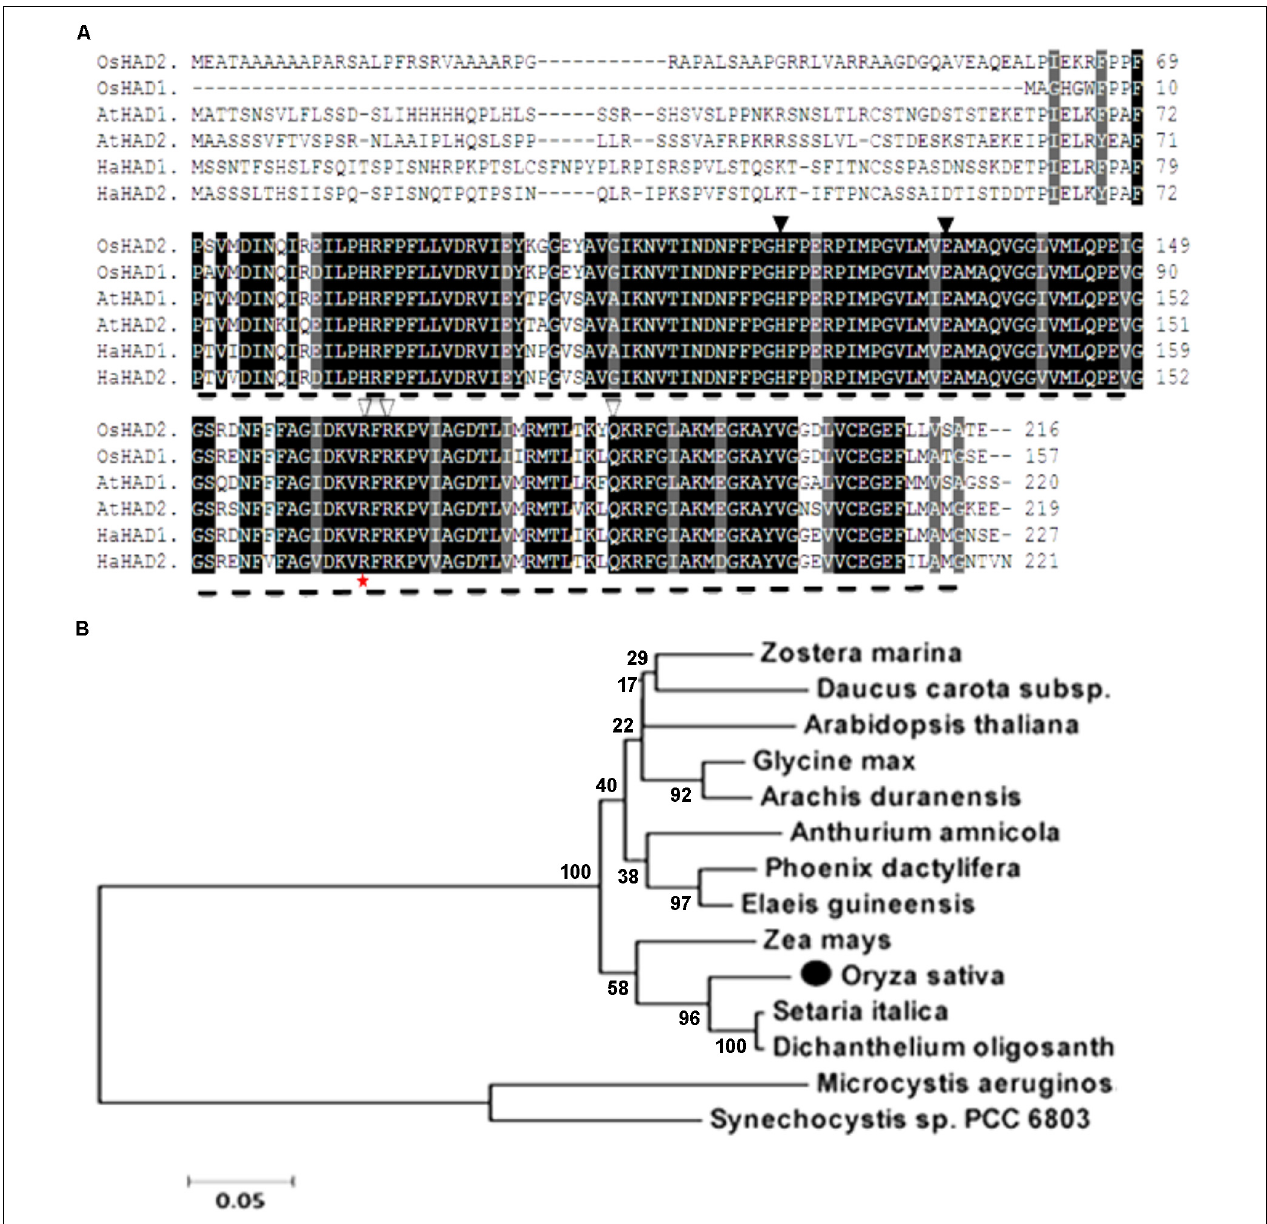
FIGURE 6 | Alignment of the predicted amino acid sequence and phylogeny of ZL16. (A) Amino acid sequence alignment of ZL16 (O sHAD1 ). Dash line denotes FabA-like domain. Identical residues are highlighted as black shadings, highly conserved residues as dark gray shadings and weakly conserved residues as light gray shadings. Black triangles indicate the active sites, and white triangles are the residues participating in the ACP recognition and binding sites. The red star indicates the mutant site in the zl16 mutant. Os, Oryza sativa ; At, Arabidopsis thaliana ; Ha, Helianthus annuus (sunflower). (B) Phylogenetic analysis of ZL16 proteins (black solid dot). A maximum likelihood phylogenetic tree was constructed based on the amino acid sequences using the MAGA5.0